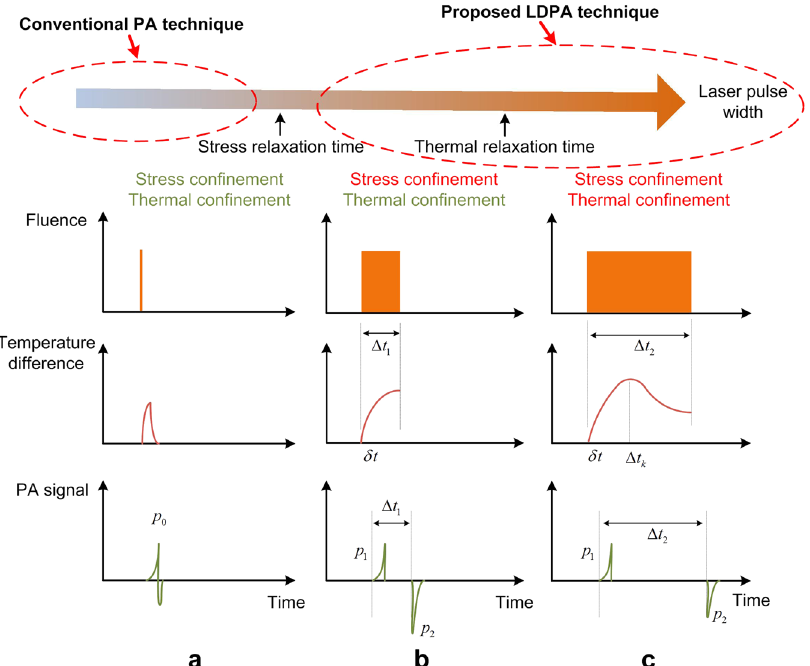
Figure 1. The fluence pattern, temperature change and PA signal waveform of ( a ) conventional short laser pulse induced PA effect with both stress and thermal confinements satisfied; ( b ) long laser pulse induced dual PA nonlinear effect with only thermal confinement satisfied, and ( c ) even longer laser pulse without thermal